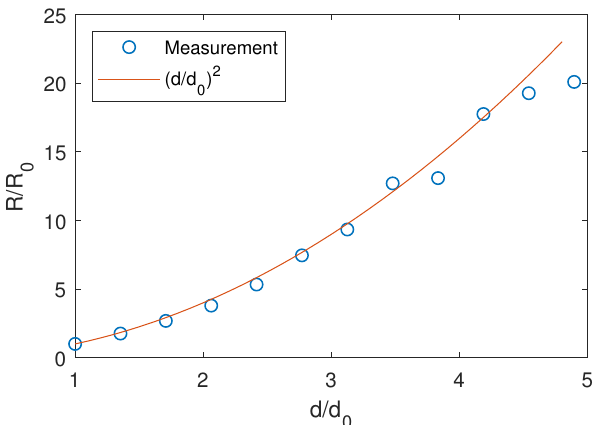
Figure 14. Normalized semi-major axis of the error ellipsoid as a function of